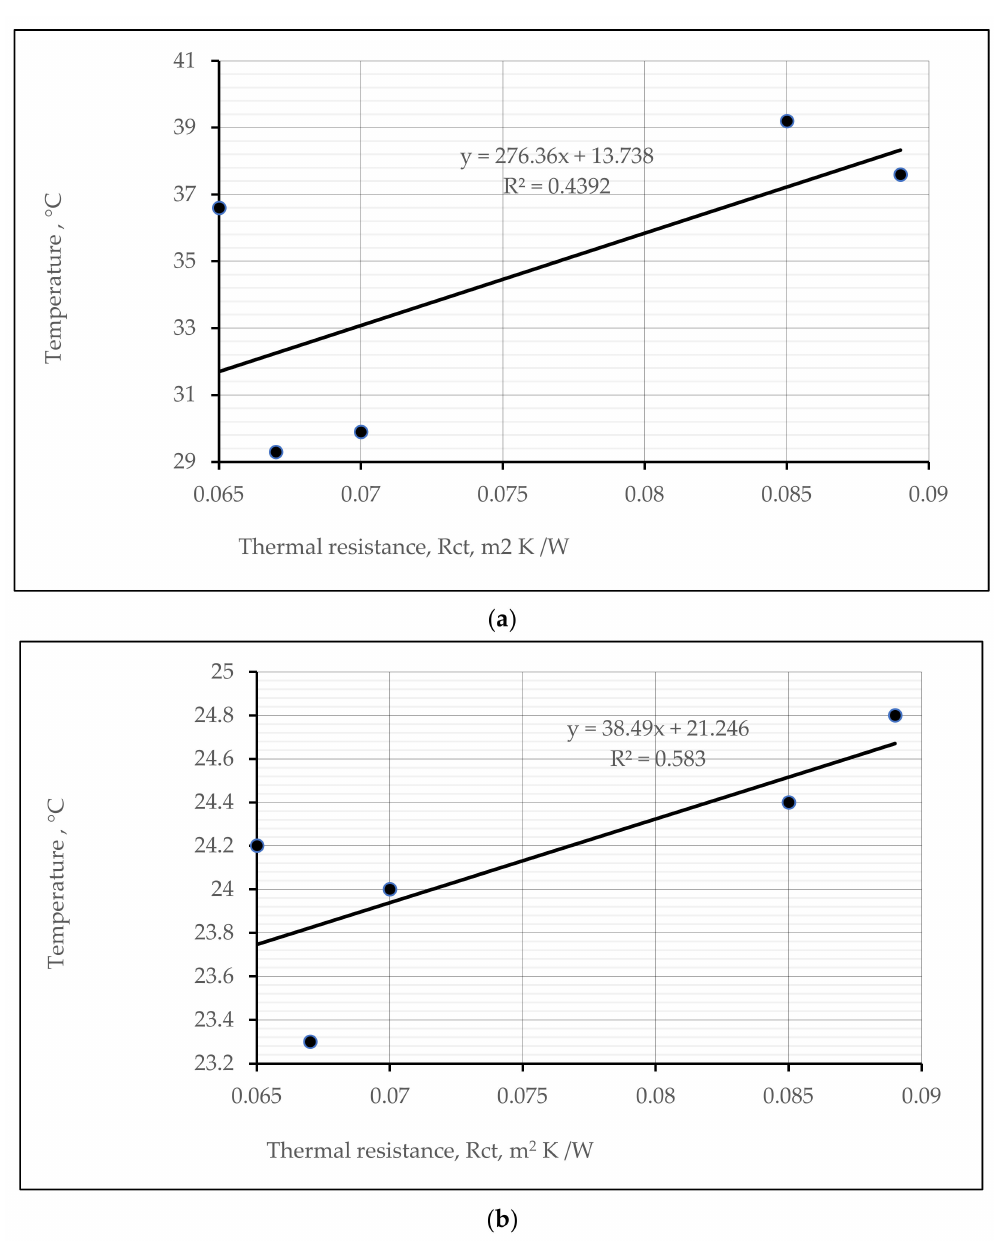
Figure 13. Relationships (by exposure to a 250 W IR lamp) between heat absorption at time 240 s temperature and thermal resistance ( a ), and heat retention at time 480 s for the temperature and thermal resistance ( b ) of different structures of